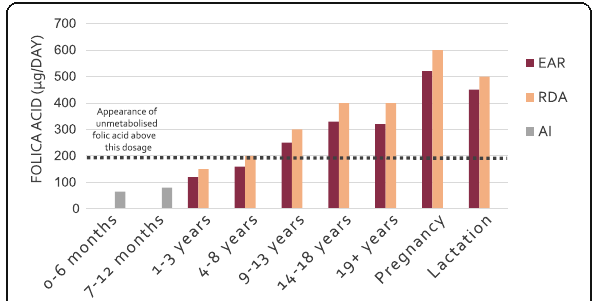
Fig. 6 Current recommendations for folic acid nutritional requirements per age. The Institute of Medicine (Food and Nutrition Board) determined the recommended daily assumption ( RDA ) and Estimated Average Requirements ( EARs ) for folate according to age and status. For infants (0 – 12 months), adequate intake ( AI ) is presented instead, as the influence of maternal nutrients can interfere with experimental evidence for RDA and EAR. During pregnancy and lactation, the requirements are higher, as the developing foetus needs high levels of folic acid. At doses above 200 μ g, unmetabolised folate is detectable in